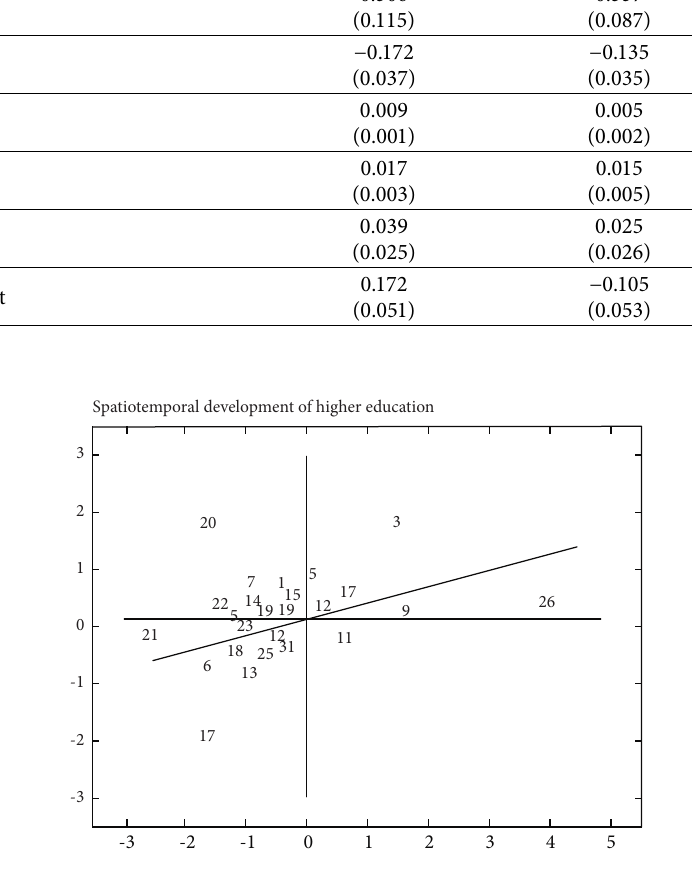
Figure 8: Local Moran’s I scatterplot of spatiotemporal development of higher education.